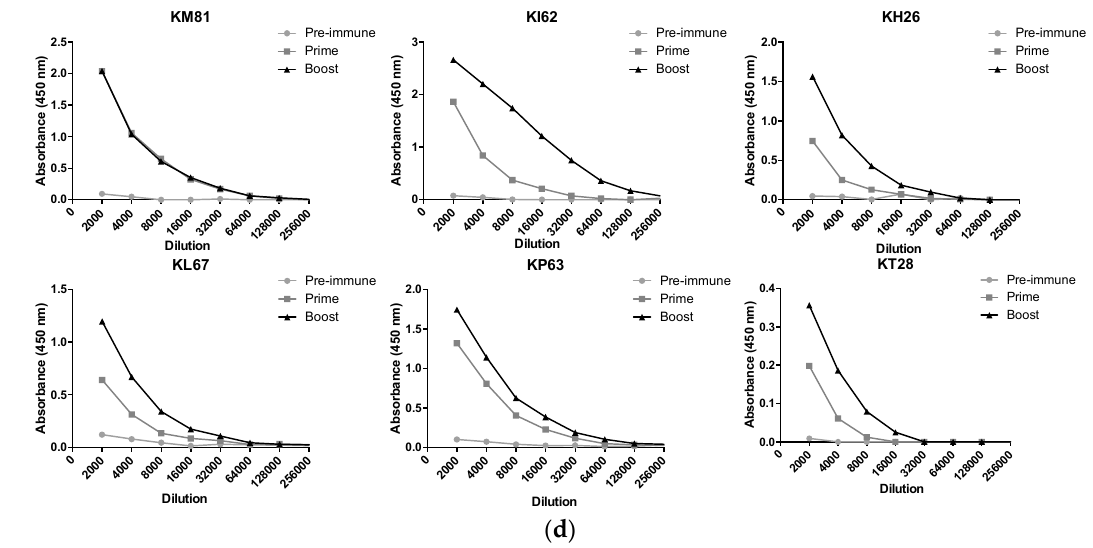
Figure 6. OMV immunization induces B. mallei -specific antibody responses in nonhuman primates. ( a ) B. mallei -specific and ( c ) OMV-specific IgG were measured in the sera of sham-immunized and ( b , d ) OMV-immunized rhesus macaques by ELISA prior to immunization (pre-immune), one month after the first dose (prime), and two weeks after the second dose (boost). Reciprocal titers are plotted against absorbance for each individual macaque.